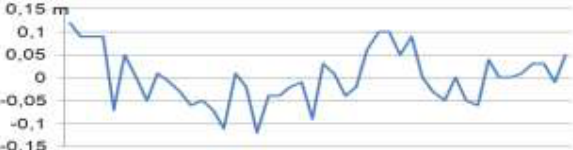
Figure 8. Averaged WV-4 y-parallax over 19 km in north-south The averaged y-parallax profiles of a Kompsat-3 stereo pair (figures 10 and 11) does not indicate a jitter. The root mean square of the averaged y-parallaxes is 9cm in east-west and 7cm in north-south direction, corresponding to approximately 0.16 pixels. This is not far away from WorldView-4. The area million image points, is quite different as for WorldView-2 – no jitter is indicated; only a homogenous distribution can be seen, corresponding to a model